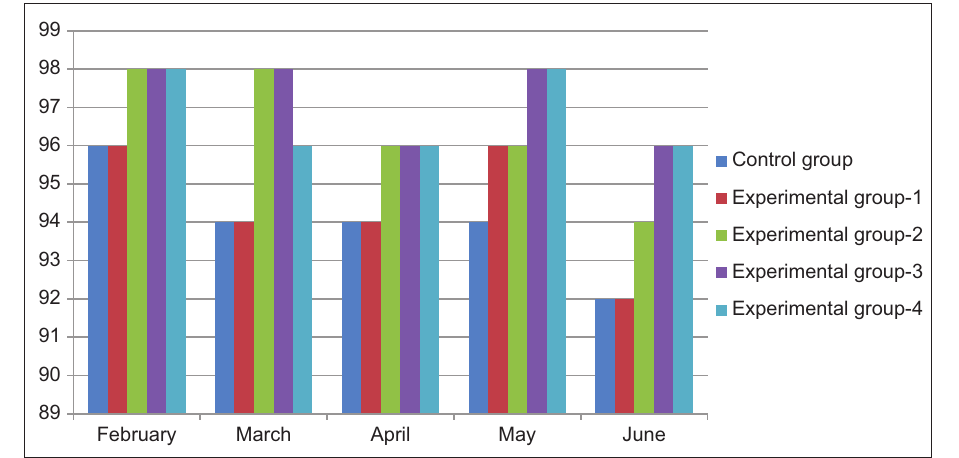
Figure-1: Adult stock survival rate